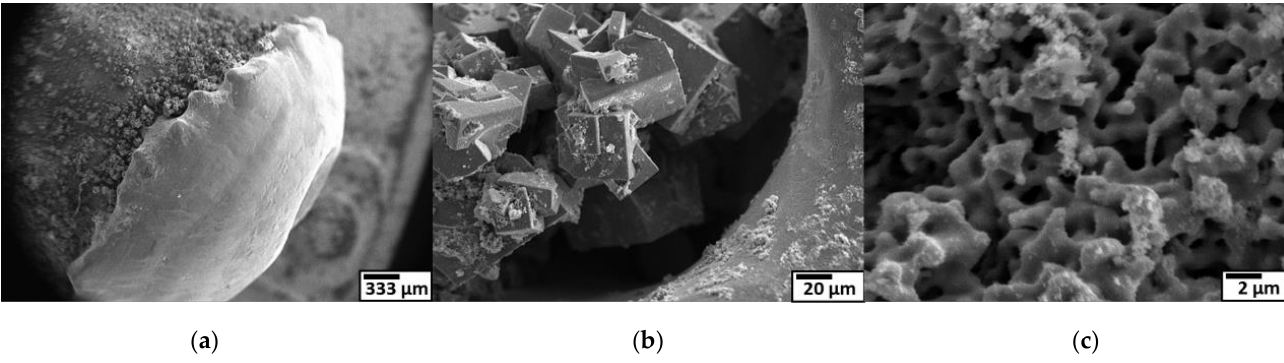
Figure 18 . Surface morphologies of Ti anode and SEM observation at low magnification (left) to high magnification (right). ( a ) anode after discharge; ( b ) dendrite particles formed behind the melted tip; ( c ) pore structure of anode surface